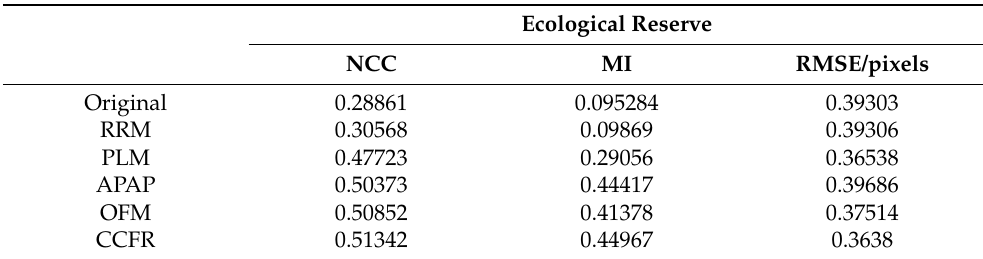
Table 4. Quantitative evaluation of the registration results in the experiment with the GF-1 and GF-2